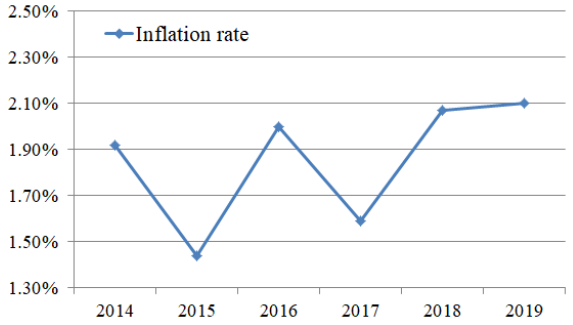
Figure 2. China’s inflation rate (2014–2019).